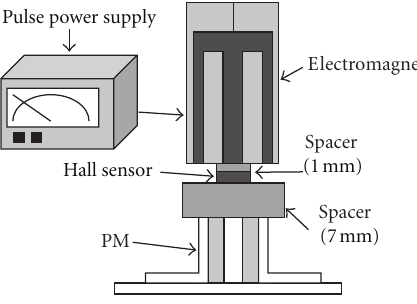
Figure 13: Measurement experiment of magnetic field.